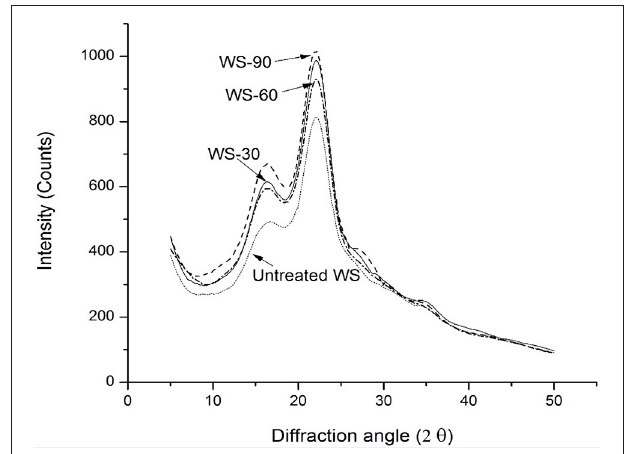
FIGURE 8 | The XRD patterns of WS